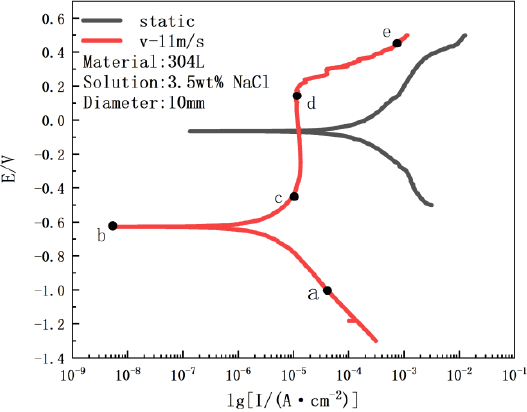
Figure 13. Polarization curves of 304 stainless steel in static and dynamic solutions.